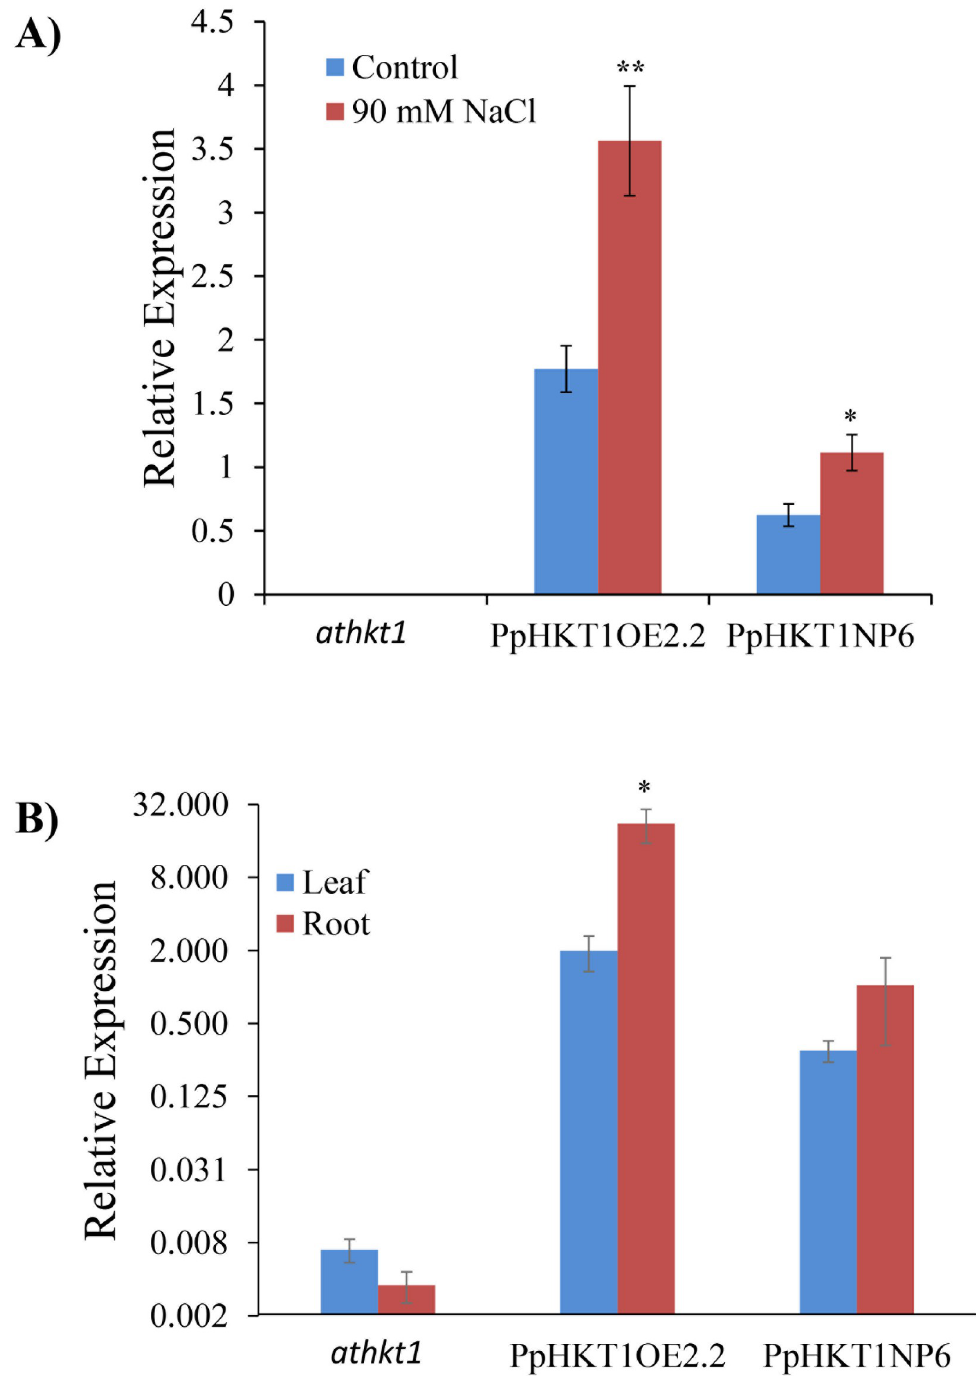
Fig 4. Relative expression of the PpHKT1 gene in athkt1 , PpHKT1OE2.2 and PpHKT1NP6. A ) Under control conditions, the athkt1 mutant showed no expression while the almond PpHKT1 variant showed some expression, which was induced under 90 mM NaCl treatment. Samples were collected 48 h after treatment with two seedlings per replicate and three replicates per lines. Experiment was repeated twice. B ) PpHKT1 expression in leaves and roots of athkt1 , PpHKT1OE2.2 and PpHKT1NP6. Expression was significantly more in the PpHKT1OE2.2 roots compared to leaves. ANOVA single factor was used to depict the statistical differences between control and 90 mM NaCl and between leaves and roots. P � 0.05 ( � ) and P � 0.001 ( ��